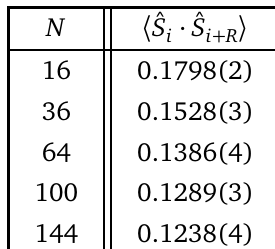
· ˆ S 〉 for different system sizes. i i + R